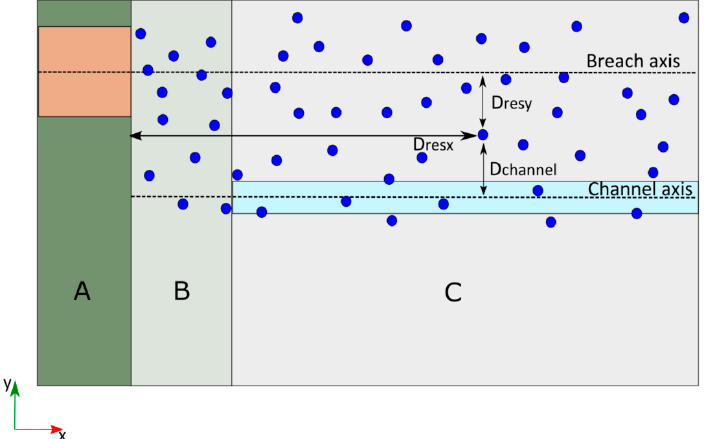
Figure 2. Scheme location of gauges (blue points) and parametrization relative to the off-stream reservoir and main channel. Main parts of the geometry: location of the off-stream reservoir (A); transition zone (B); and floodable area (C) where the main channel and floodplains are defined.